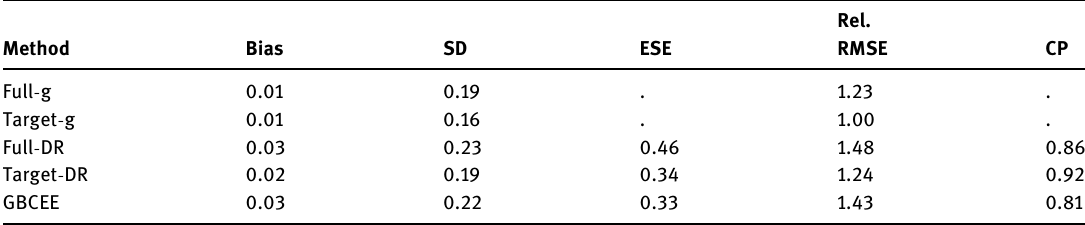
Table A8: Results of Scenario 2D ( continuous exposure, binary outcome ) with n 1,000 =